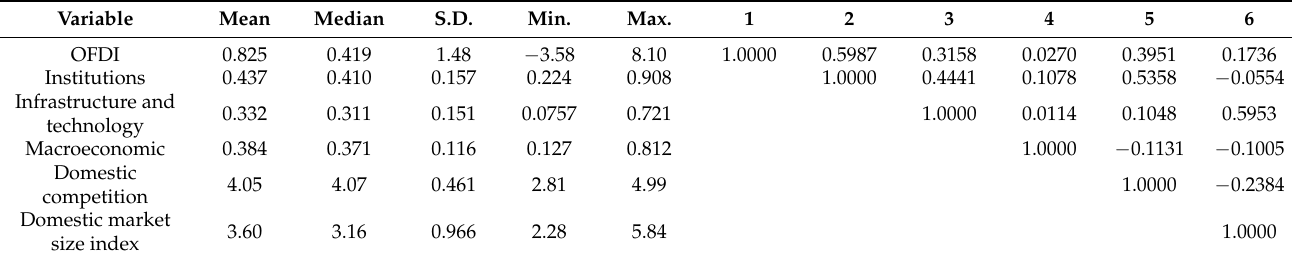
Table 3. Descriptive statistics and correlation